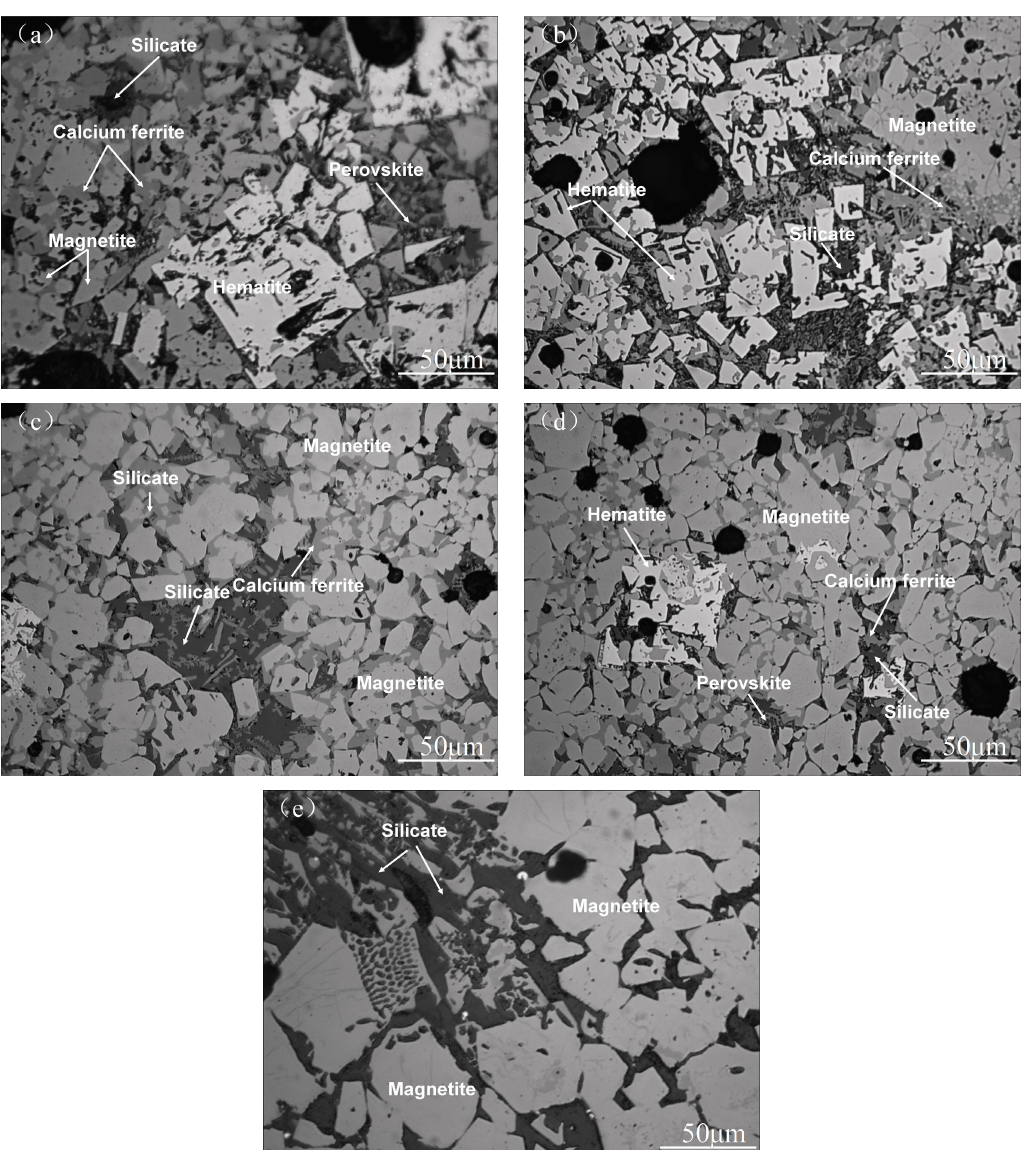
Figure 7. Microstructure of the sinter with various MgO concentrations: ( a ) ω (MgO) = 2.66%; ( b ) ω (MgO) = 2.96%; ( c ) ω (MgO) = 3.26%; ( d ) ω (MgO) = 3.56%; ( e ) ω (MgO) = 3.86%.